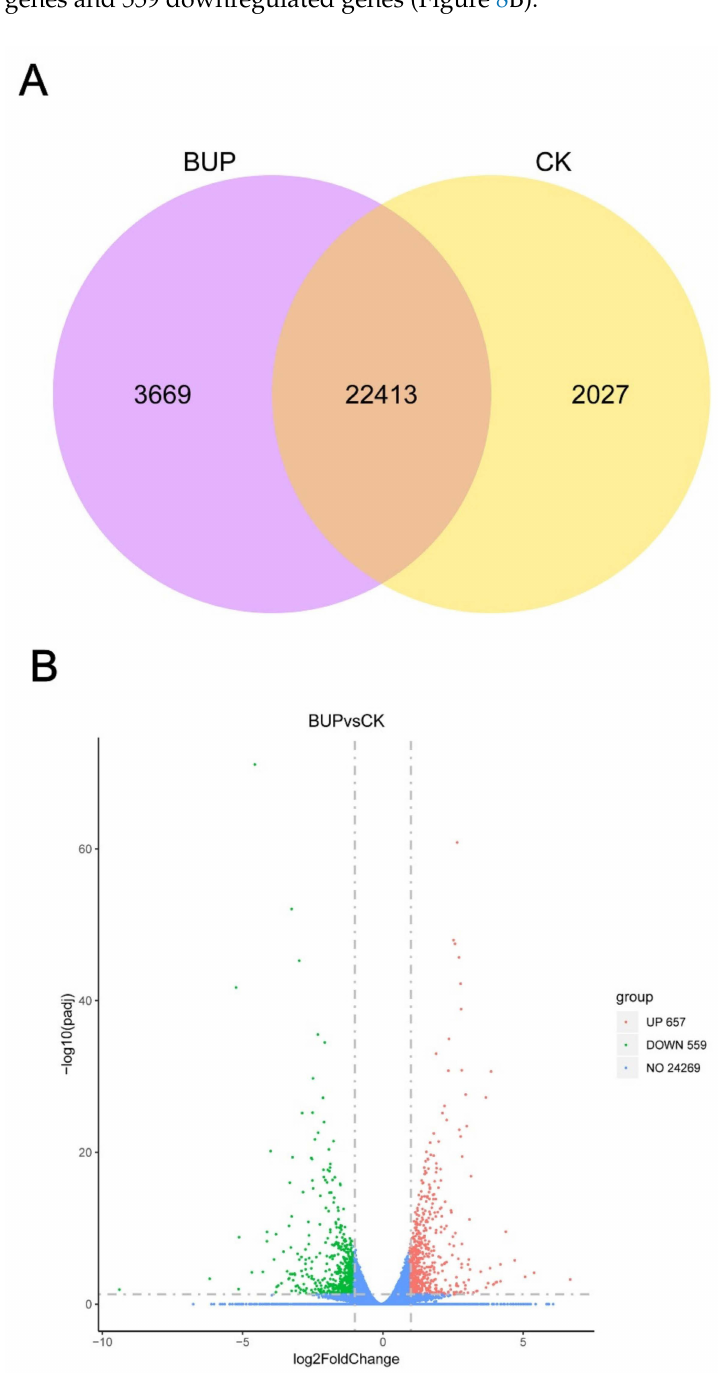
Figure 8. Analysis of expressed genes, showing: ( A ) Venn diagram of co-expressed and uniquely expressed genes between CK and BUP, ( B ) volcano map of DEGs. CK—control cells; BUP—BUP treated